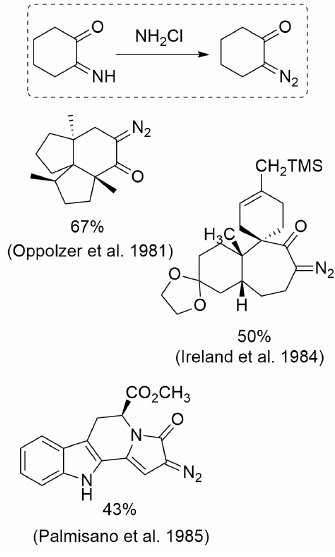
Figure 40 - The Forster’s reaction. TRIAZENE